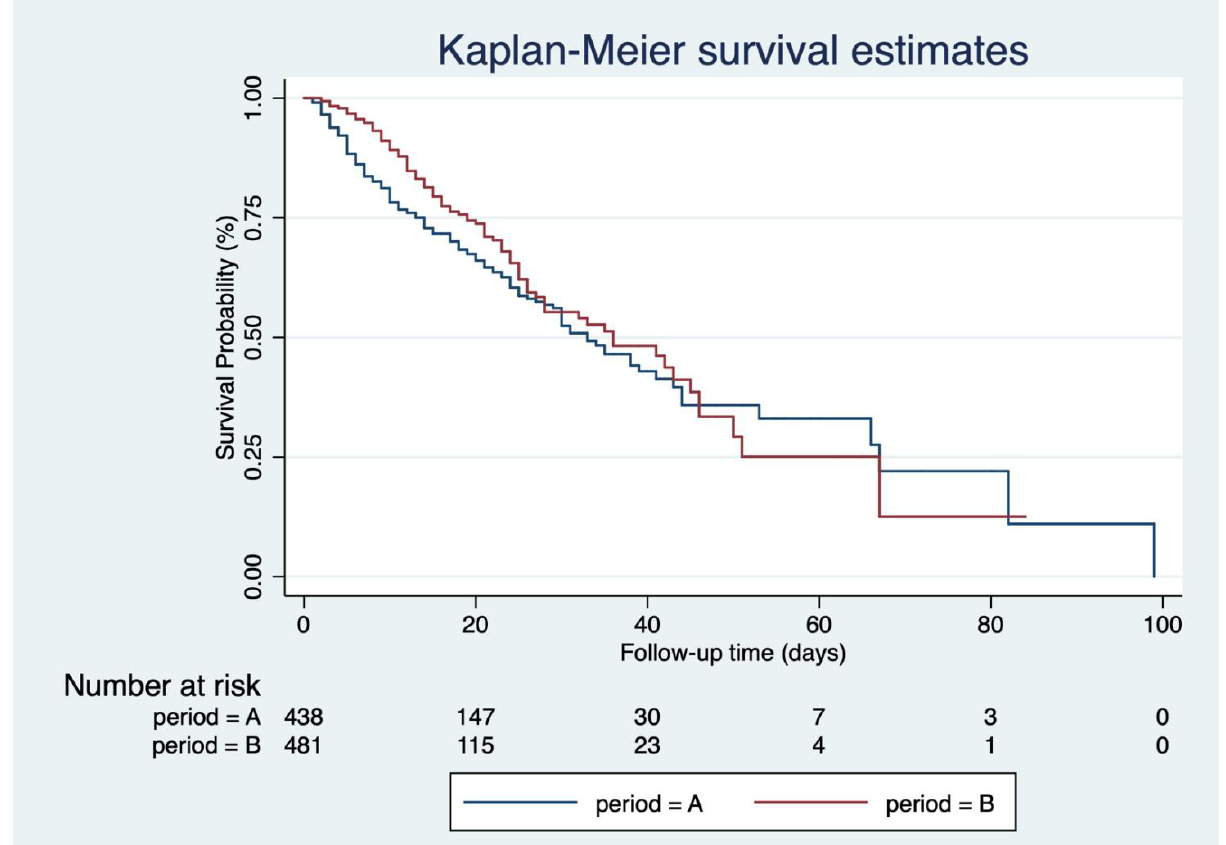
Figure 1. Kaplan – Meier overall survival estimates for SARS-CoV-2-infected patients. Figure 1. Kaplan–Meier overall survival estimates for SARS-CoV-2-infected